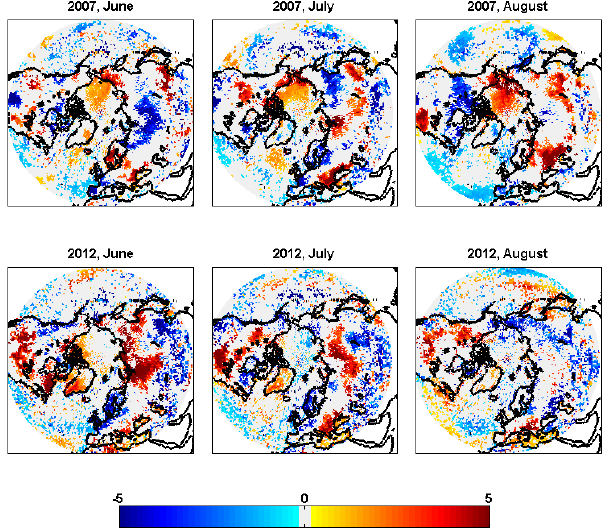
Fig. 9. Surface skin temperature [K] anomalies for the JJA months Fig. 9: Surface skin temperature [K] anomalies for the JJA months of 2007 (top row) and of 2007 (top row) and 2012 (bottom row). 2012 (bottom row).